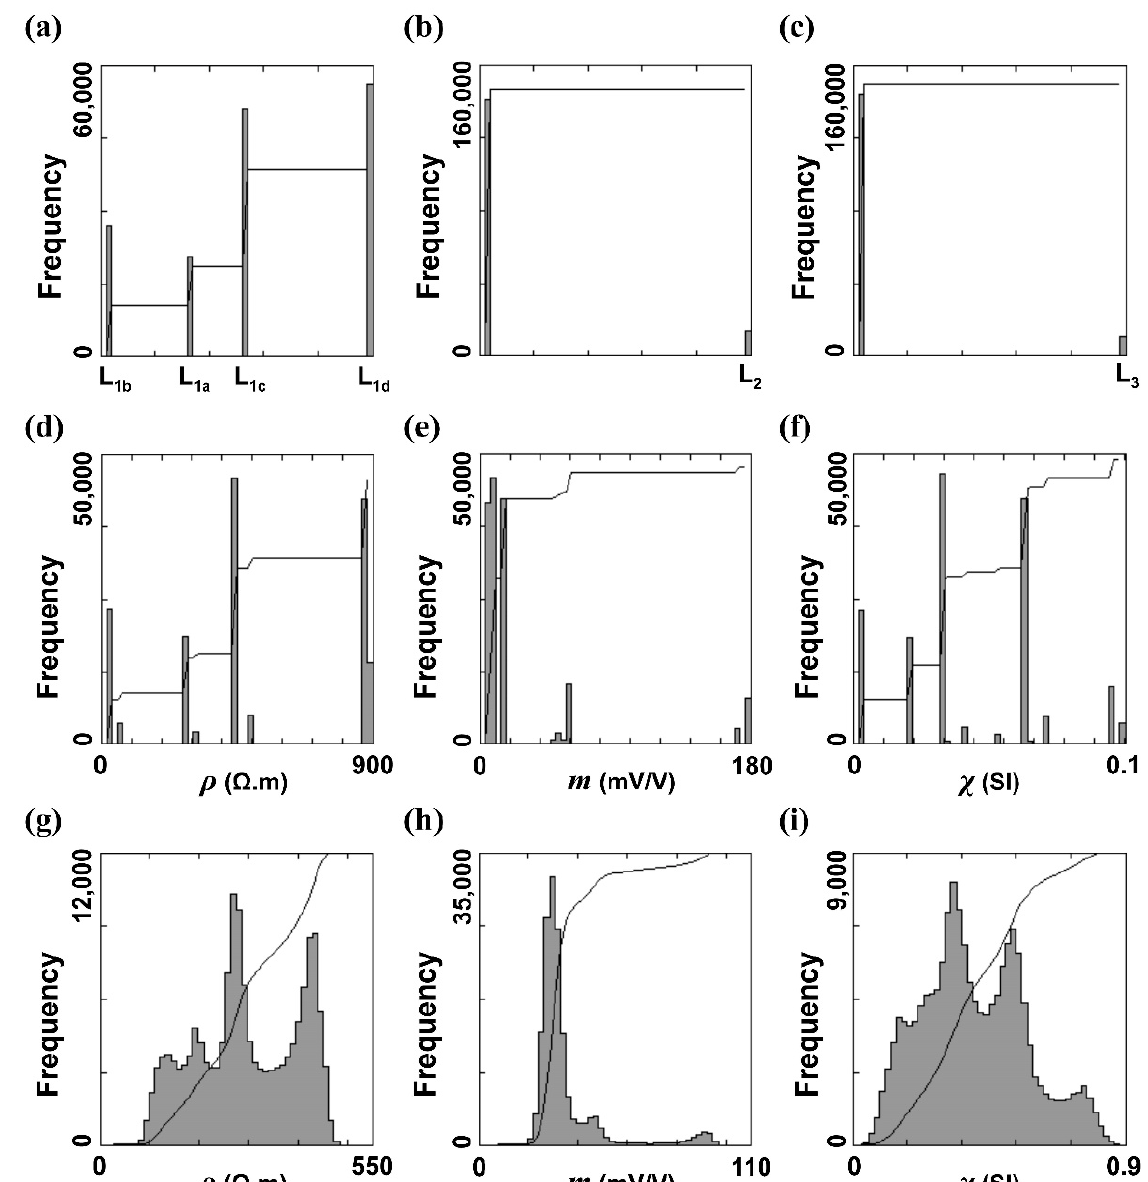
Figure 6. Histograms of simulated physical properties: ( a – c ) Histograms of the original litho-codes used for geological modeling; ( d – f ) Histograms of the mixed physical properties (noise-free); ( g – i ) Histograms of the mixed physical properties with added non-Gaussian noise. Multimodal nature of the physical properties is a result of the mixing process. The solid curve indicates the cumulative distribution function.